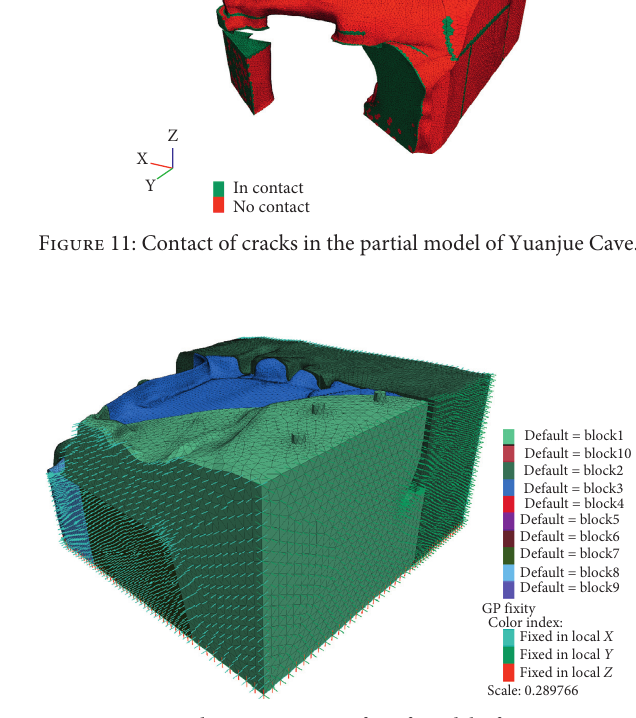
Figure 12: Boundary constraints of roof model of Yuanjue Cave.